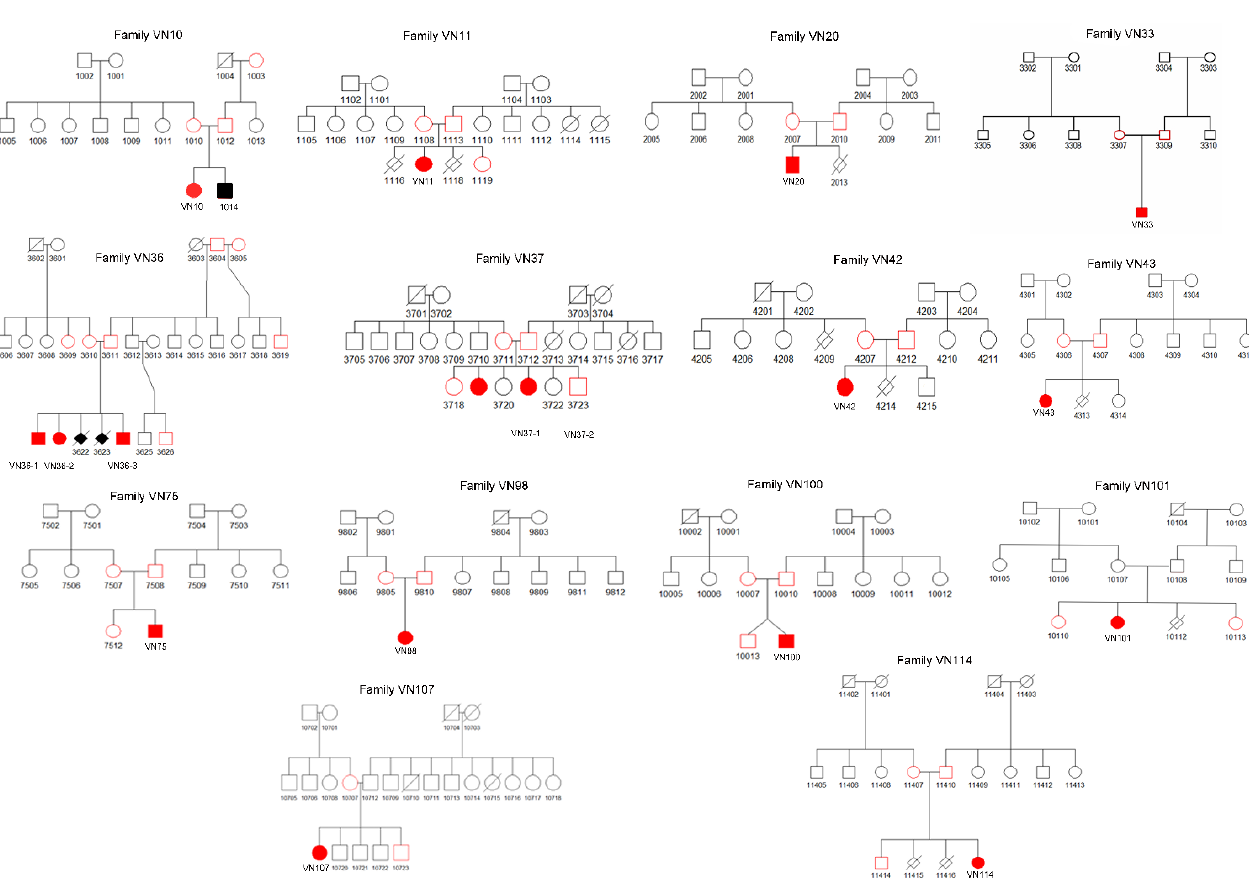
Figure 3. Patient pedigree trees. Squares indicate males, circles indicate females, diamonds indicate individuals of unknown sex. Affected individuals are pictured with filled-in symbols. Deceased family members are represented with a cross line. Patients and family members whose samples were available for the study are indicated in red.